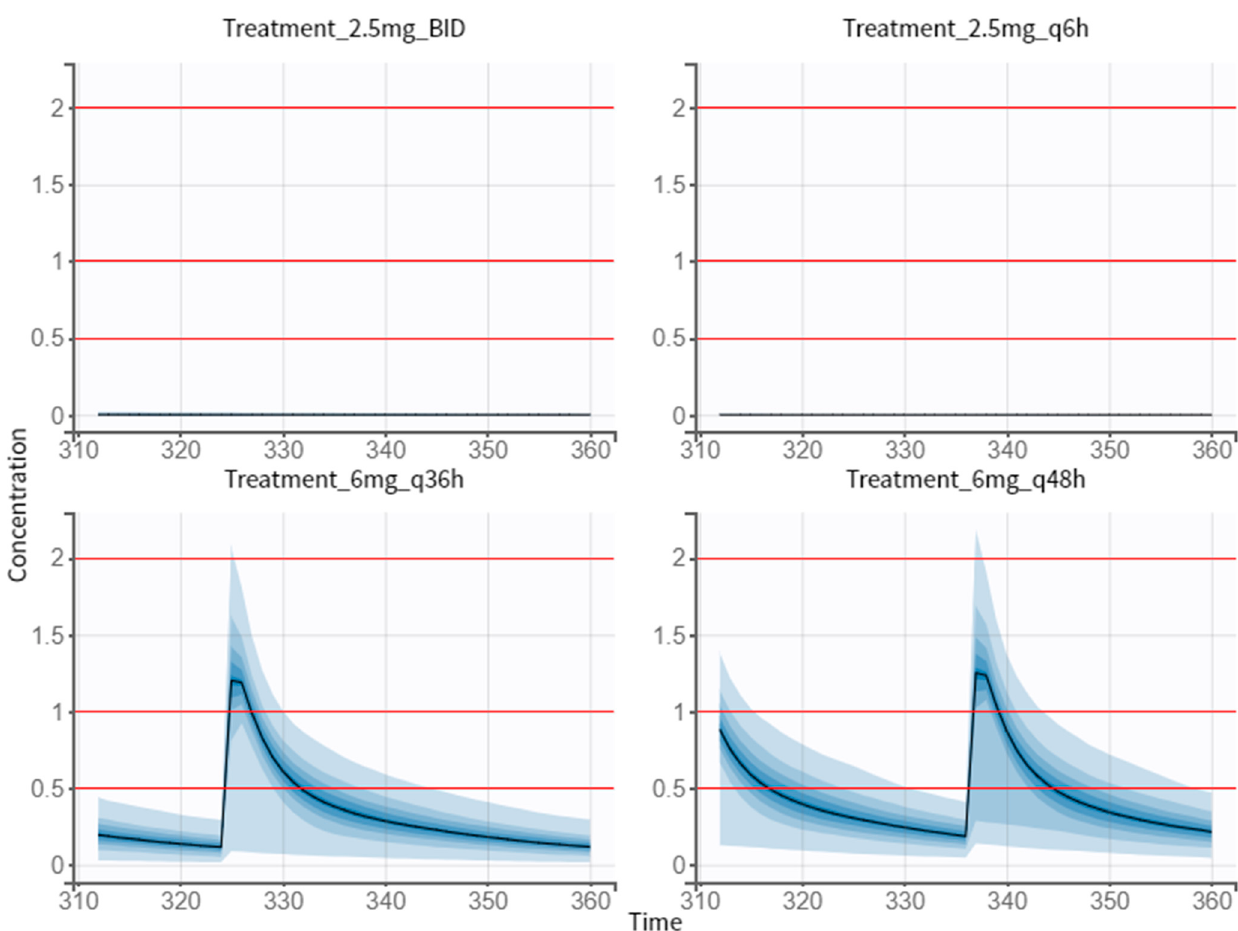
Figure 7. Simulations of dose regimen of 2.5 mg twice a day (Treatment 2.5 mg BID), 2.5 mg every 6 h (Treatment 2.5 mg q6 h), 6 mg every 36 h (Treatment 6 mg q36 h), and 6 mg every 48 h (Treatment 6 mg q48 h). Output distributions that represent the variability between individuals with visual cues of the concentration prediction intervals. The visual cues demonstrating the efficacy (1–2 ng/mL) and safety (0.5 ng/mL) are displayed as red lines. Table 7. Values of the efficacy and safety target for each group of